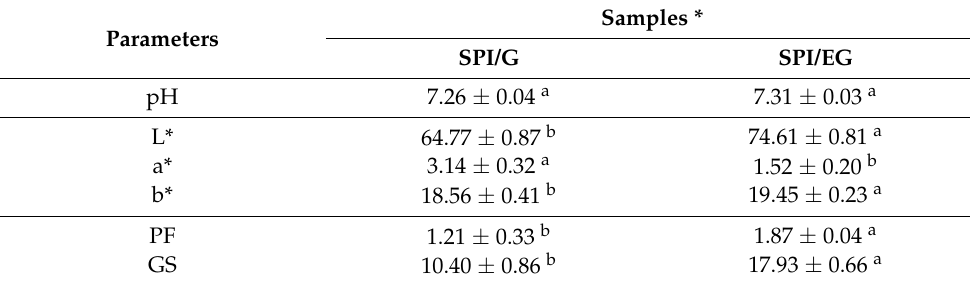
Table 2. pH values, color parameters ((L*) lightness, (a*) redness and (b*) yellowness) and penetration test parameters (puncture force (PF, N) and gel strength (GS, Nmm)) of oil-free SPI gels (SPI/G) and SPI emulsion gels with chia oil